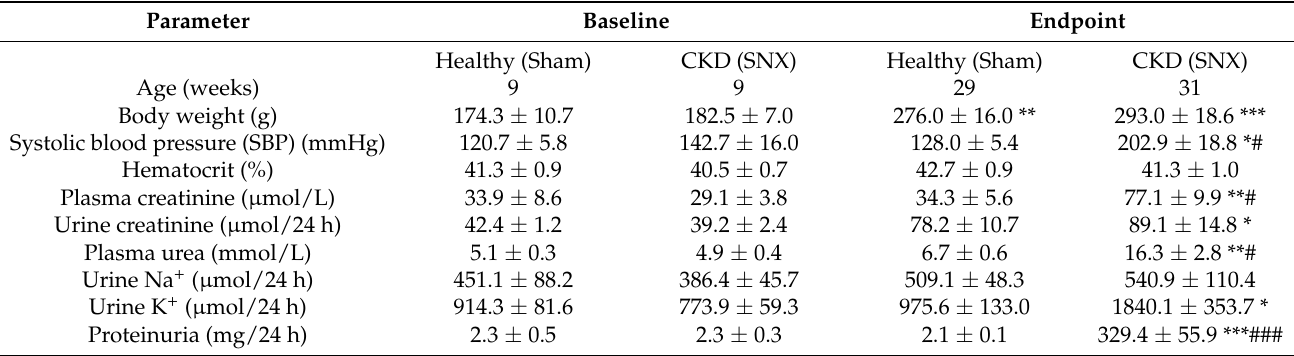
Figure 5. Effect of PBUTs on NF- κ B signaling and the role of NF- κ B on PBUTs-mediated caspase-1 activity and IL-1 β production in ciPTEC-OAT1. ( A ) Representative images (20×) and ( B ) quantification of p65 nuclear expression in ciPTEC-OAT1 after 1 h incubation with IS (200 μ M, 1 mM, 2 mM), UT mix (1×, 2.5×), LPS (200 μ g/mL) or TNF- α (100 ng/mL). ( C ) Relative mRNA expression of IL-1 β upon 4 h exposure to either IS (200 μ M, 1 mM, 2 mM) or UT mix (1×, 2.5×), in Table 2. Main parameters (baseline and endpoint) evaluated in healthy (Sham; n = 3) and CKD (SNX; n = 4) animals 1 . Parameter